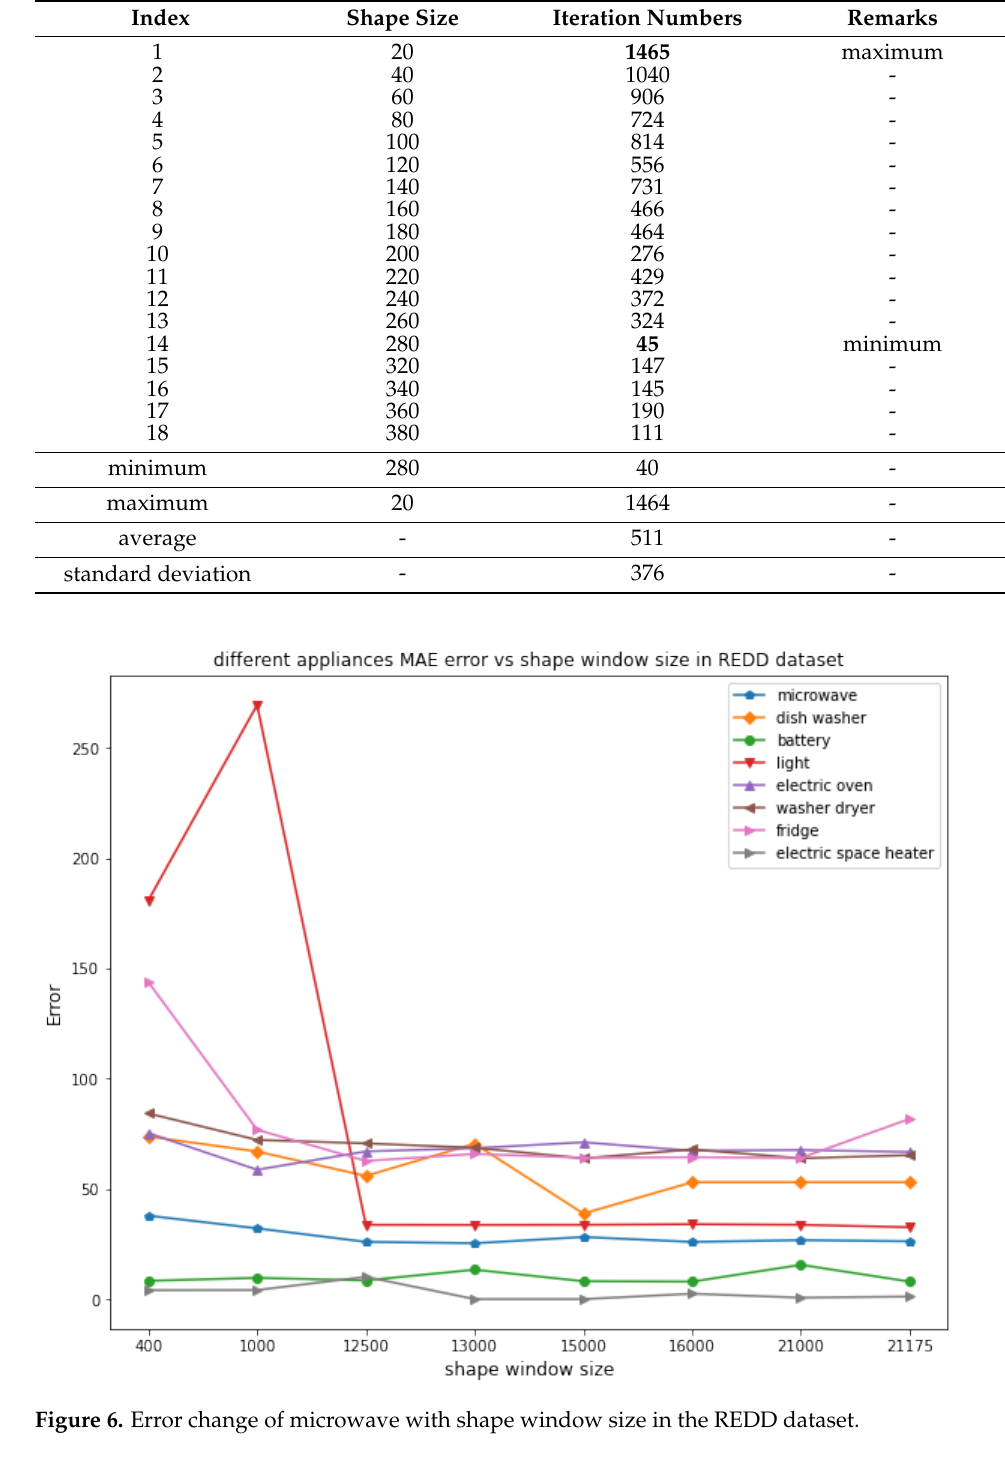
Table 4. Statistical measures on minimum, maximum, average, and standard deviation values of errors for different presented cases.